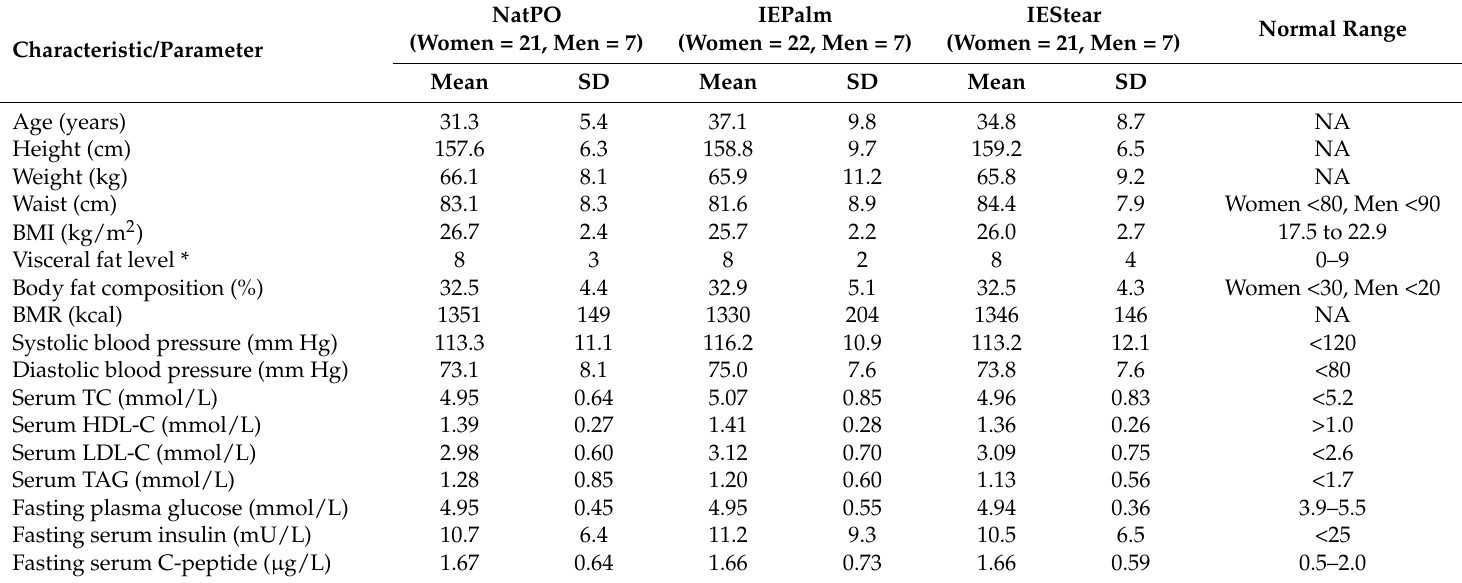
Table 3. Characteristics of each group after two weeks of run in (women = 64, men =